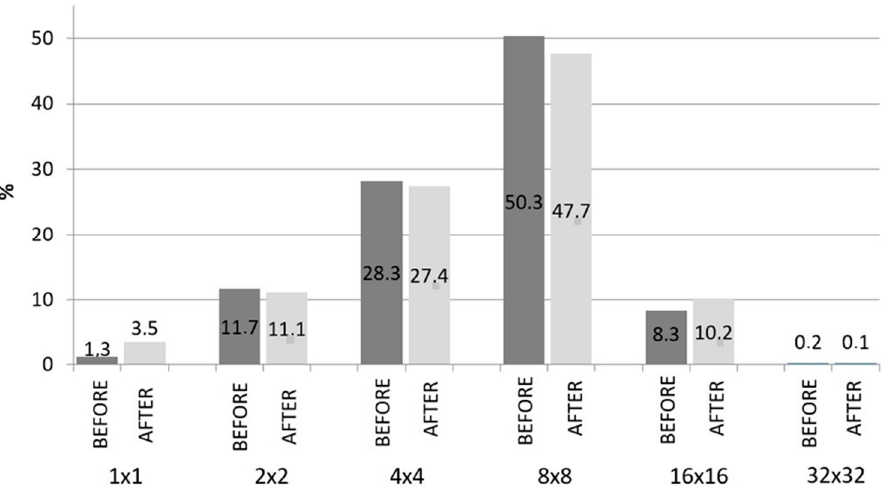
Figure 6. Change in the number of blocks with sides of 1 × 1, 2 × 2, 4 × 4, 8 × 8, 16 × 16 and 32 x 32